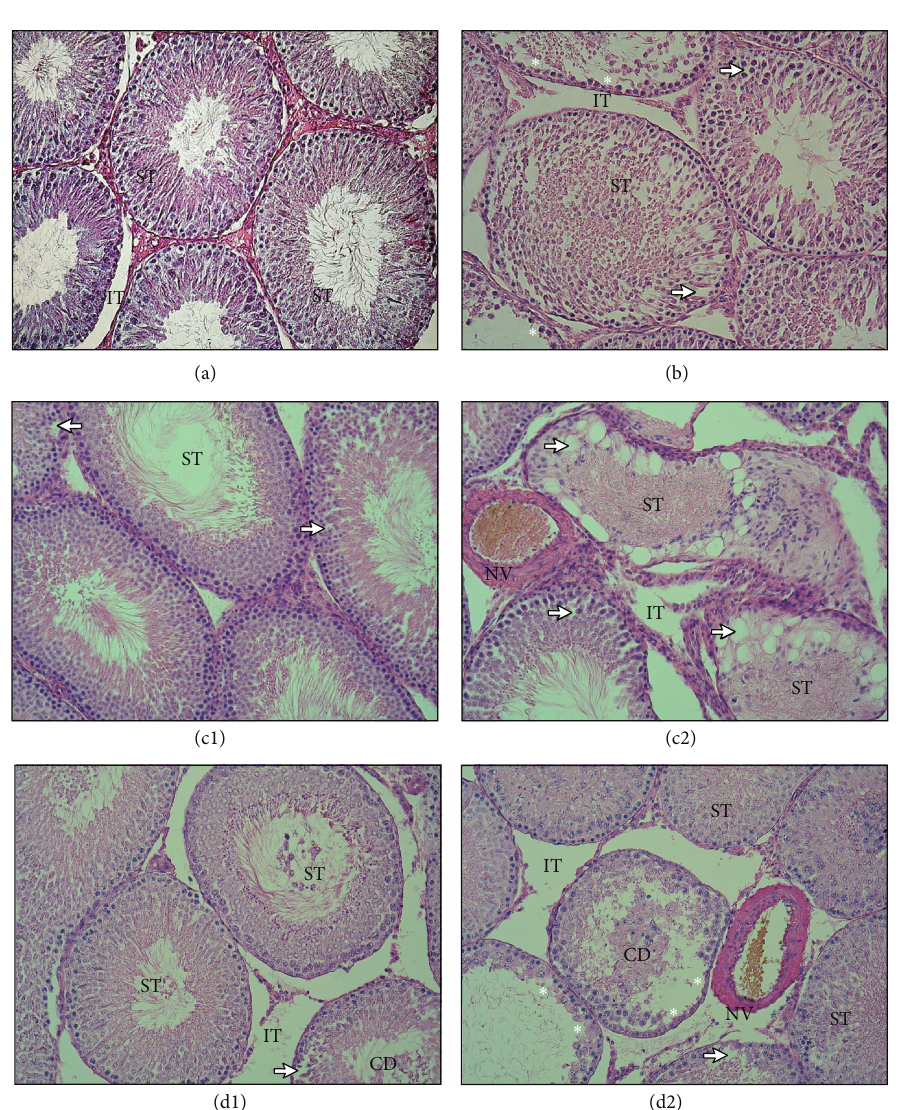
Figure 1: Photomicrographs showing histology of testicular tissue from control group (a), group exposed to cadmium at a dose of 30 mg/L (b), group exposed to diazinon at a dose of 40 mg/L (c1, c2), and group exposed to cadmium at a dose of 30 mg/L and diazinon at a dose of 40 mg/L (d1, d2). ST: seminiferous tubules, IT: interstitial tissue, CD: cellular debris, NV: necrotizing vasculitis, arrows: intraepithelial empty spaces, and stars: seminiferous tubules lined only by Sertoli cells (hematoxylin-eosin, original magnification ×